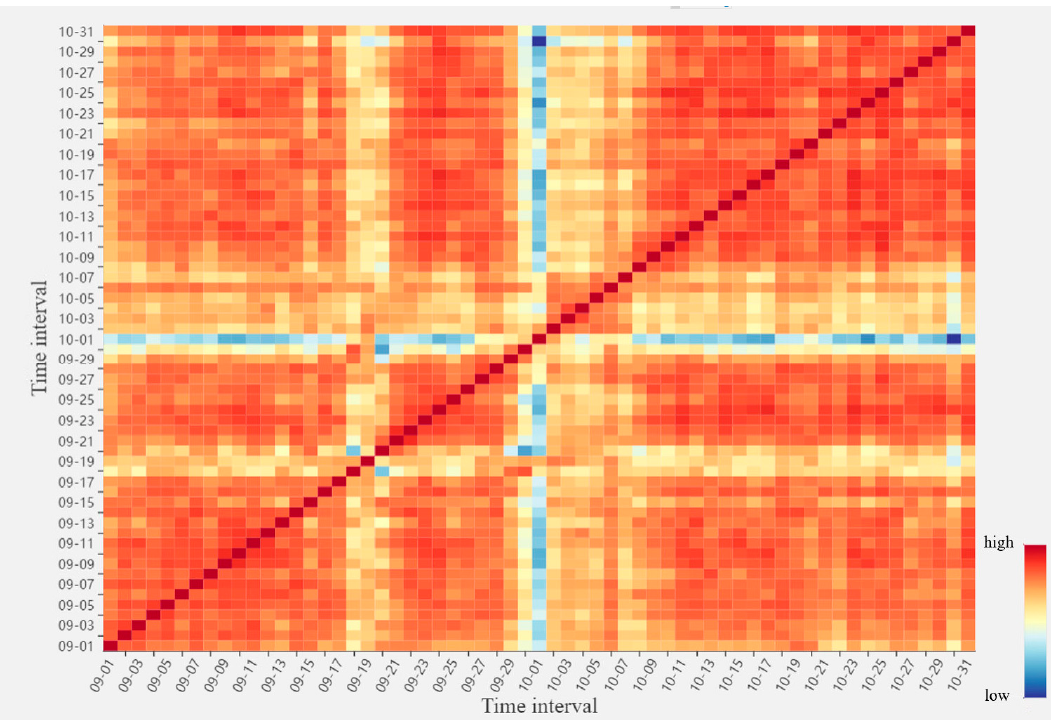
Figure 7. The similarity matrix of mobility vectors at the scale of day.